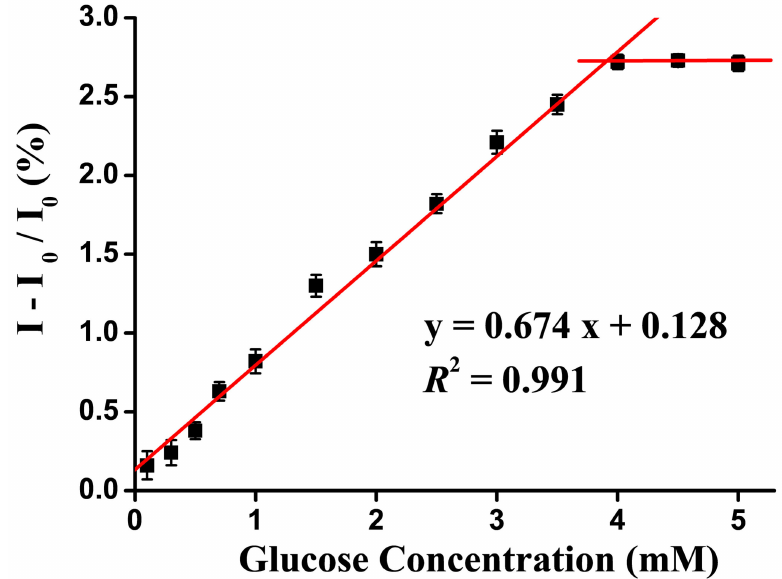
Figure 5. Percentage of emission change as a function of tear glucose concentration calibration curve. (N =